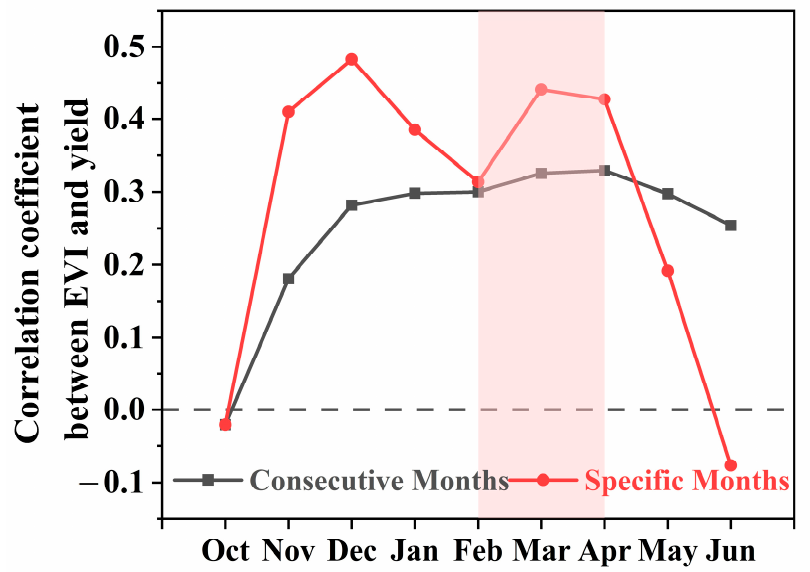
Figure 5. The correlation coefficient between Enhanced Vegetation Index (EVI) and yield during the whole growing season. Consecutive Months represent the correlation coefficient for each month which includes the previous months’ information; specific months represent the correlation coefficient for the specific month. The red rectangle indicates the peak season.